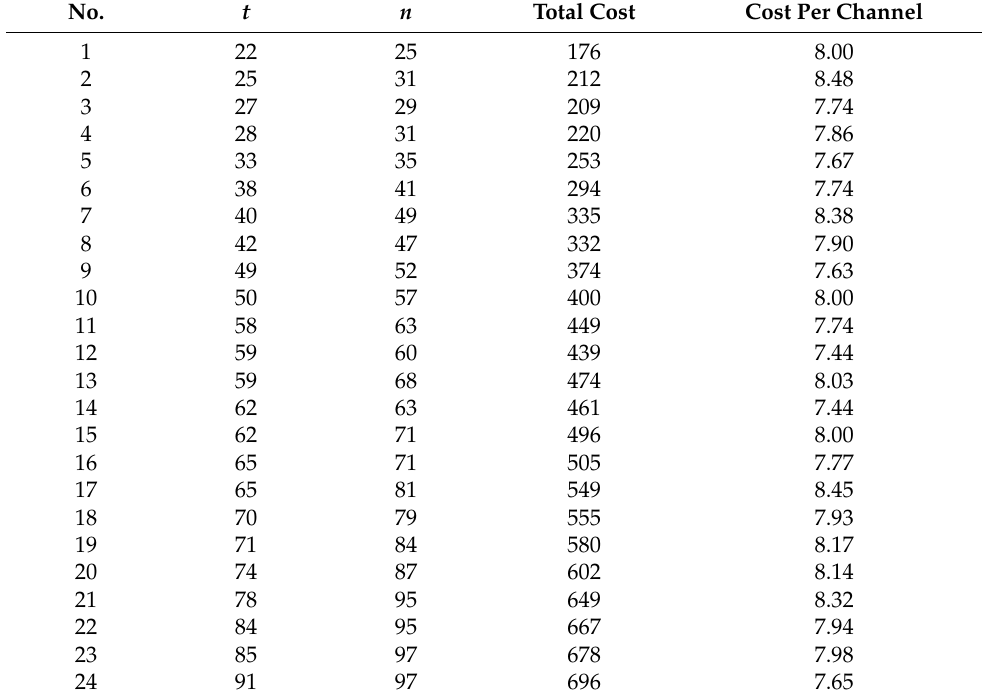
Table 6. Results of the logic synthesis for selected registers of the DT-LFSR type.